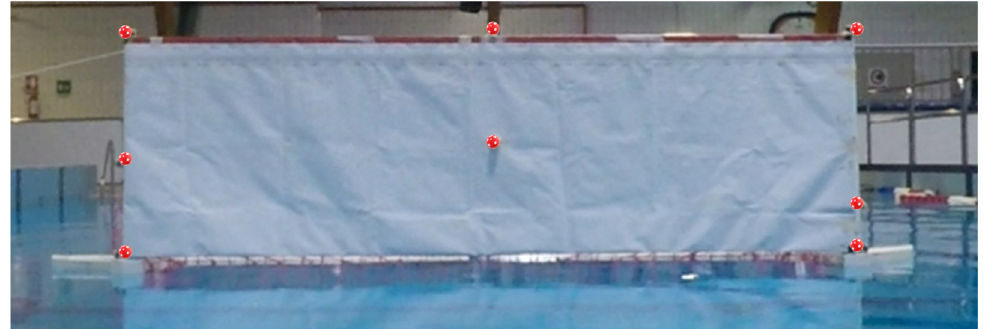
Figure 2. A customized PVC panel with reference points used for the calibration procedure.